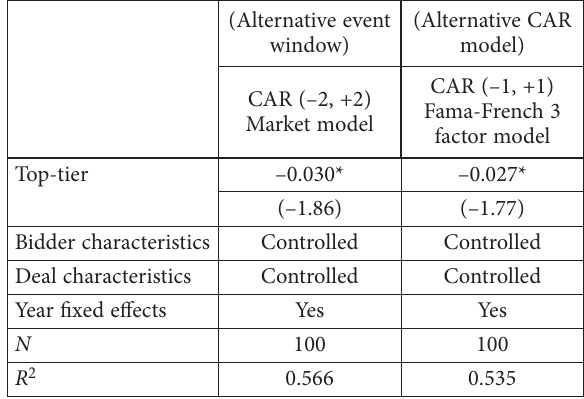
Table 5. Cross-sectional regression analysis of bidder